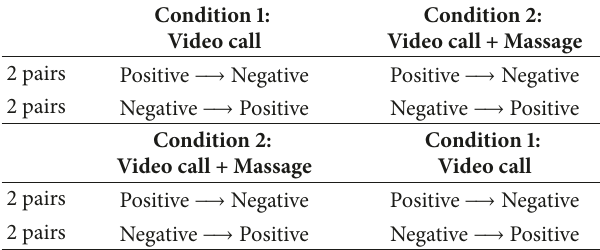
Table 2: Existing haptic communication devices categorized by interactions